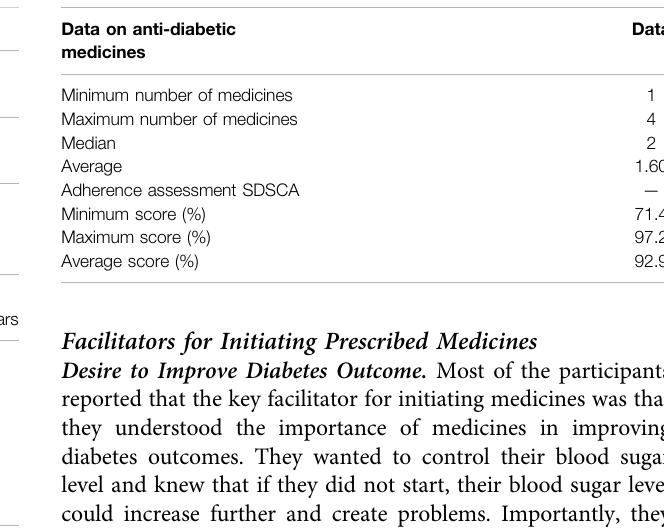
TABLE 2 | Assessment of medication adherence using SDSCA ( n (cid:1)